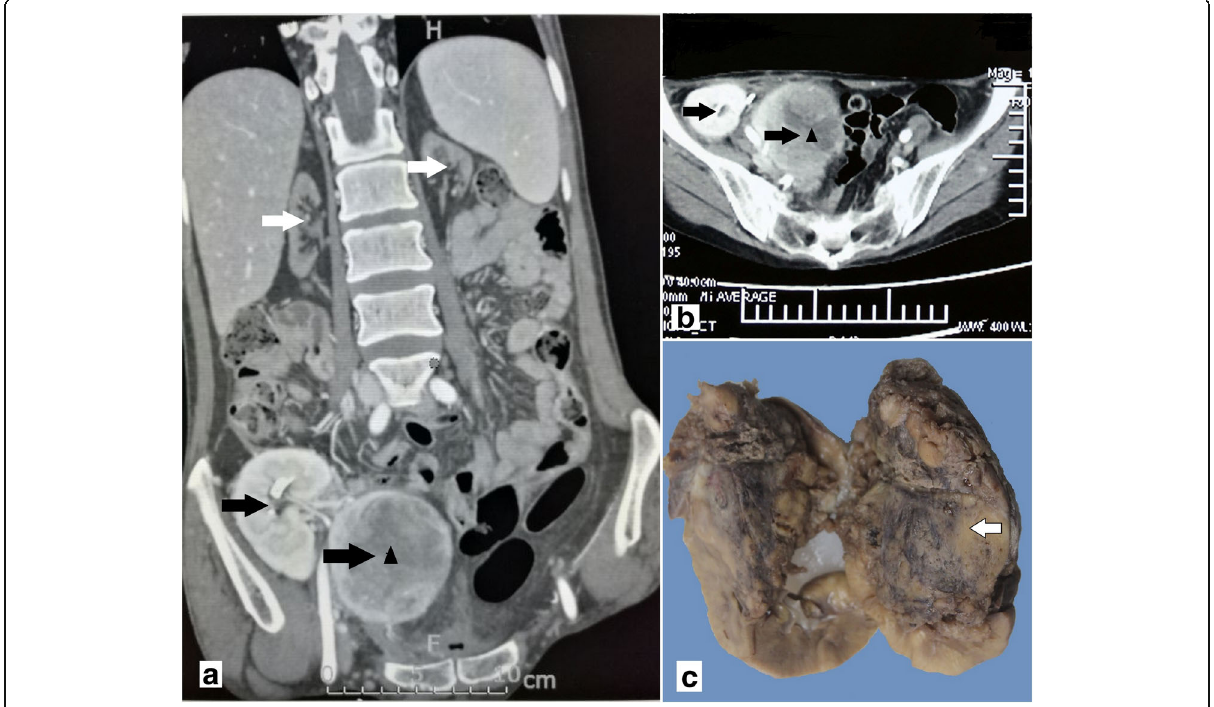
Fig. 1 Computed tomography (CT) scan revealed that both original kidneys exhibited atrophy ( a , white arrows) and a large mass ( a and b , triangle) measuring 7.4 × 6.3 × 6.0 cm with a mixed density in the upper pole of the inner transplanted kidney ( a and b , black arrows). c . Macroscopic features of MRT of the transplanted kidney. The cut surface of the mass was white to grayish